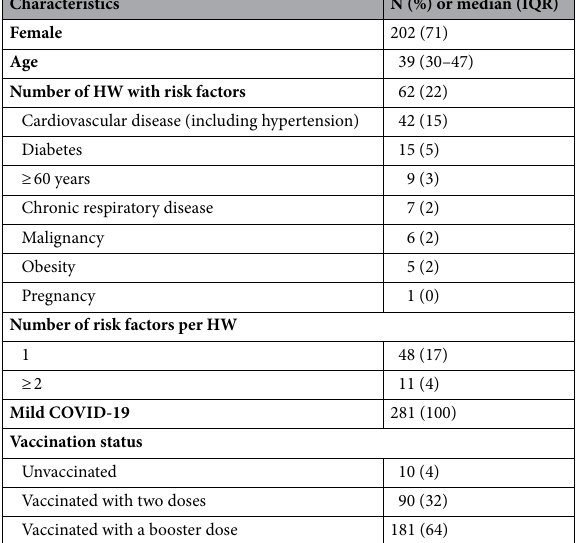
Table 1. Characteristics of 281 healthcare workers (HW) of Hospital das Clinicas (University of São Paulo) with reinfection by SARS-CoV-2 during 2 years of the pandemic (March 10, 2020–March 10, 2022).